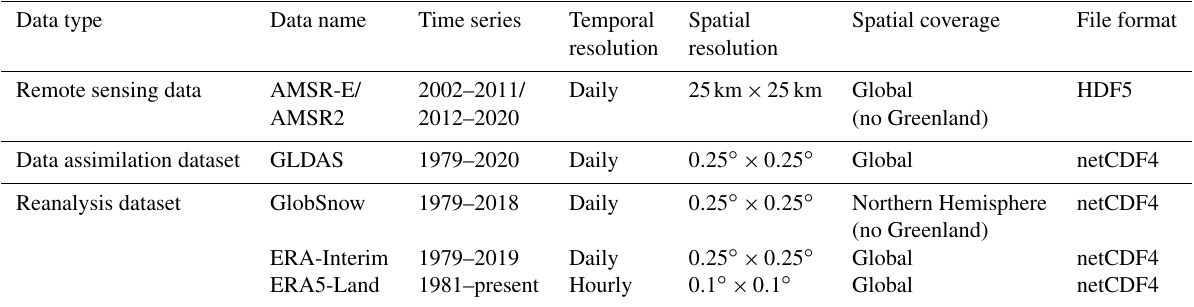
Figure 1. The DEM and snow survey stations of the research region. The right panel (b) shows the DEM, and the left panel (a) shows the SWE observational stations. HSSC, hemispheric-scale snow course; RSSD, the Russian snow survey station. The spatial range of the RRM SWE product is consistent with that of the DEM. Table 1. Introduction to the SWE